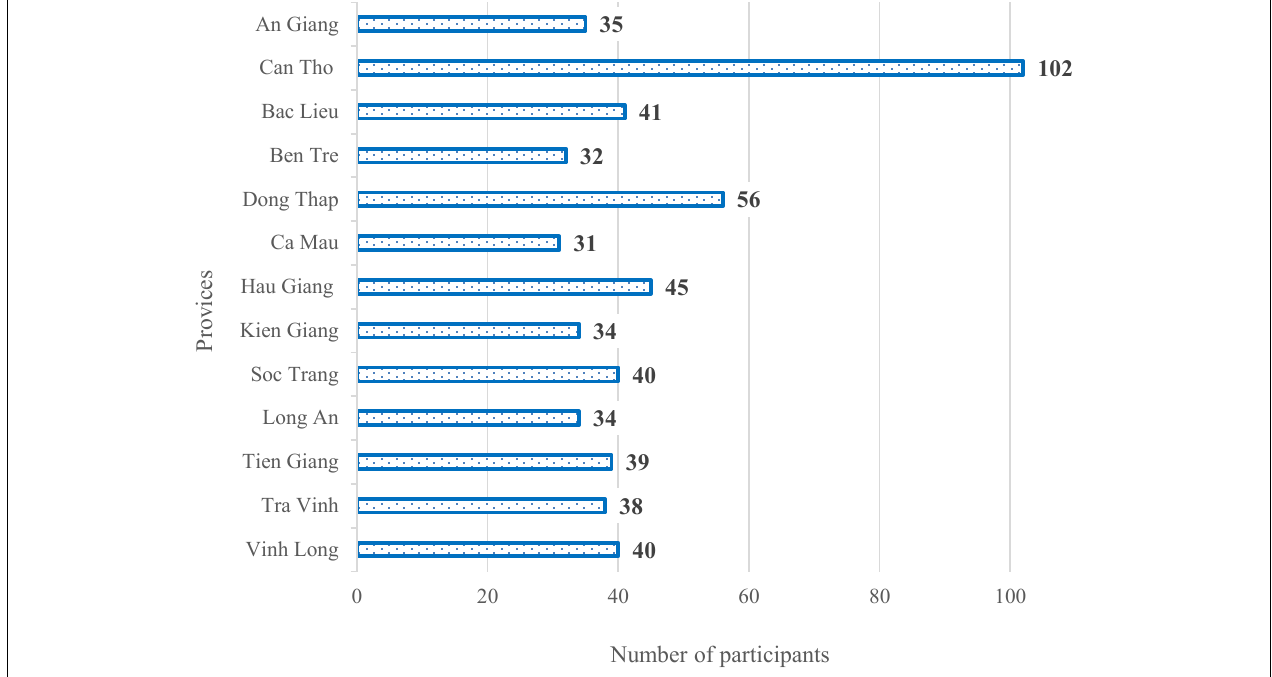
Respondents #1, #91, and #355 said that : “I am afraid of losing my life because of the COVID.” Twelve other students showed their expectation not to lose anyone due to the pandemic, resulting from the fact that they have witnessed a lot of stories about people who died and the sorrowfulness that their families suffered. All depicted a very blue picture that became a phobia for everyone on earth.